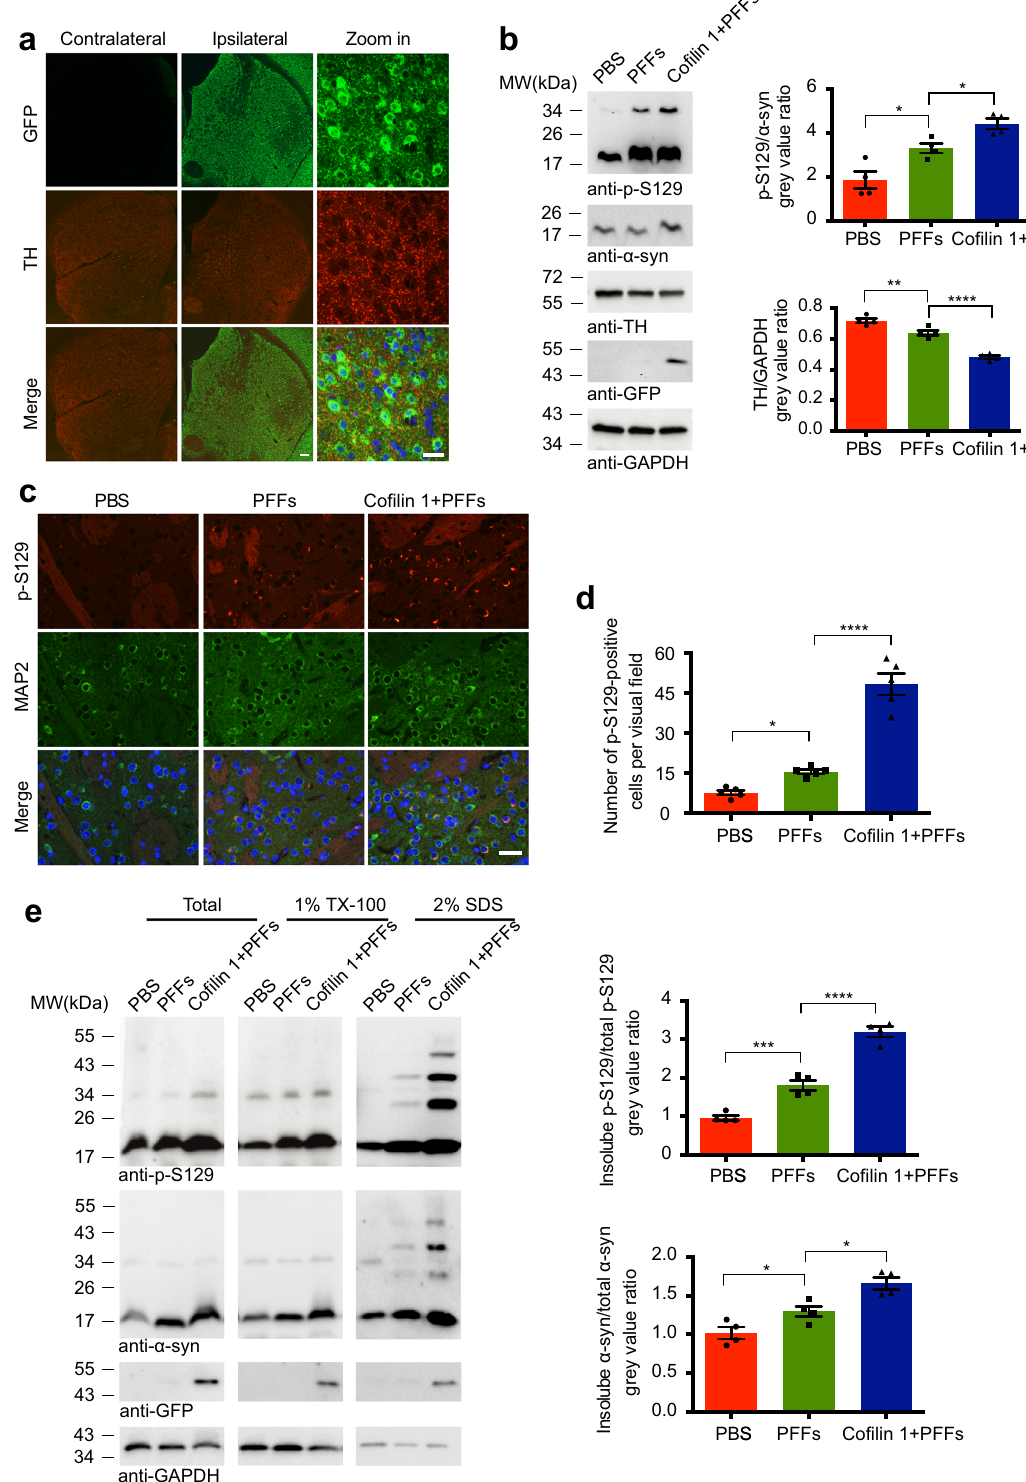
Fig. 3 Overexpression of co fi lin 1 promotes α -synuclein aggregation in vivo. a Immuno fl uorescence showing the expression of GFP-co fi lin 1 in the striatum. Scale bar, 100 μ m; Zoom in Scale bar, 20 μ m. b Western blot detection of TH, total α -synuclein and p-S129 α -synuclein in the striatum of the mouse brain. Data are mean ± SEM; n = 4; * P < 0.05, ** P < 0.01, **** P < 0.0001 by one-way ANOVA. c , d Immuno fl uorescence images showing the expression of p-S129 α -synuclein in the striatum. Scale bar, 20 μ m. Data are mean ± SEM; n = 5; * P < 0.05, **** P < 0.0001 by one-way ANOVA. e Western blot showing the aggregation of α -synuclein into higher-molecular-weight species in the right striatum of mice, especially when co fi lin 1 was overexpressed. Data are mean ± SEM; n = 4; * P < 0.05, *** P < 0.001, **** P < 0.0001 by one-way